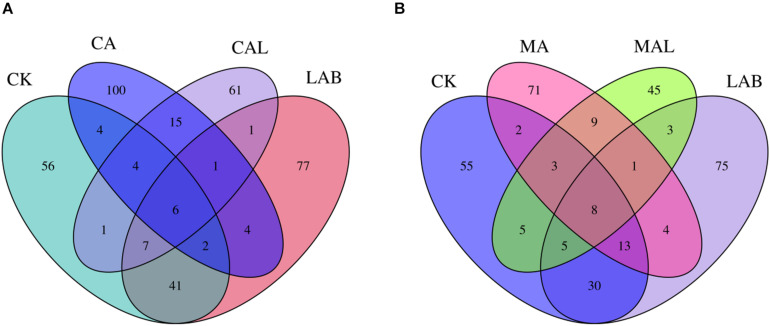
Venn analysis of OTUs for CF silage treated with CA and Lactobacillus plantarum
(A) or MA and Lactobacillus plantarum
(B). CK, control; LAB, Lactobacillus plantarum; MA, malic acid; MAL, malic acid + Lactobacillus plantarum; CA, citric acid; CAL, citric acid + Lactobacillus plantarum.